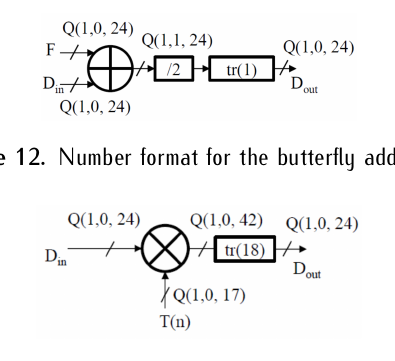
Figure 13. Number format for the twiddle factor multiplication.